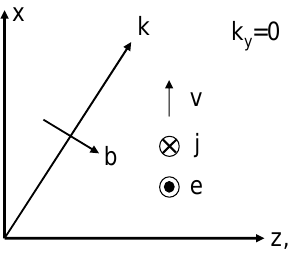
Fig. 10. The structure of a compressional ULF wave mode for ideal MHD and k y =0 (Cross,